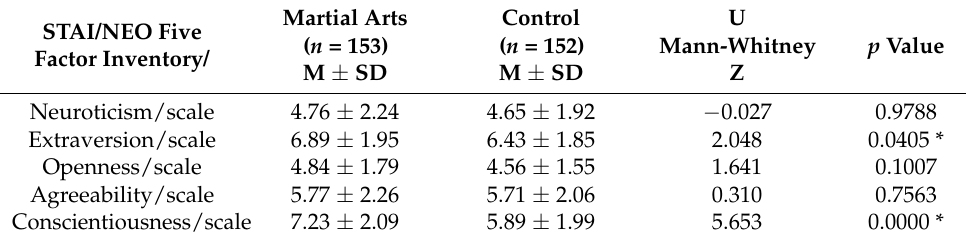
Table 3. Analysis of NEO Five-Factor Inventory results in martial arts subjects and in